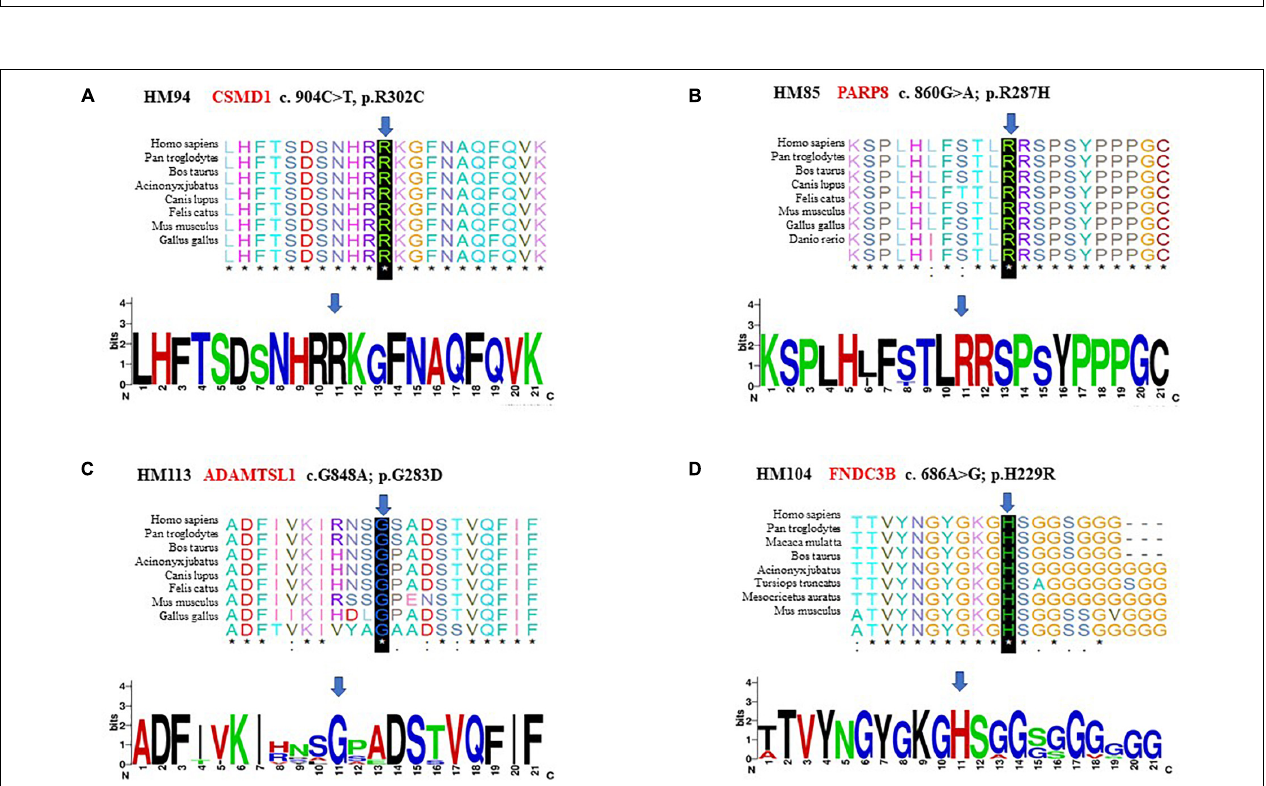
FIGURE 6 | Conservation analysis revealed evolutionary conservation of the mutation. It shows multiple alignments of the amino acids from different species. The arrow indicates the location of the mutation (A–D) .